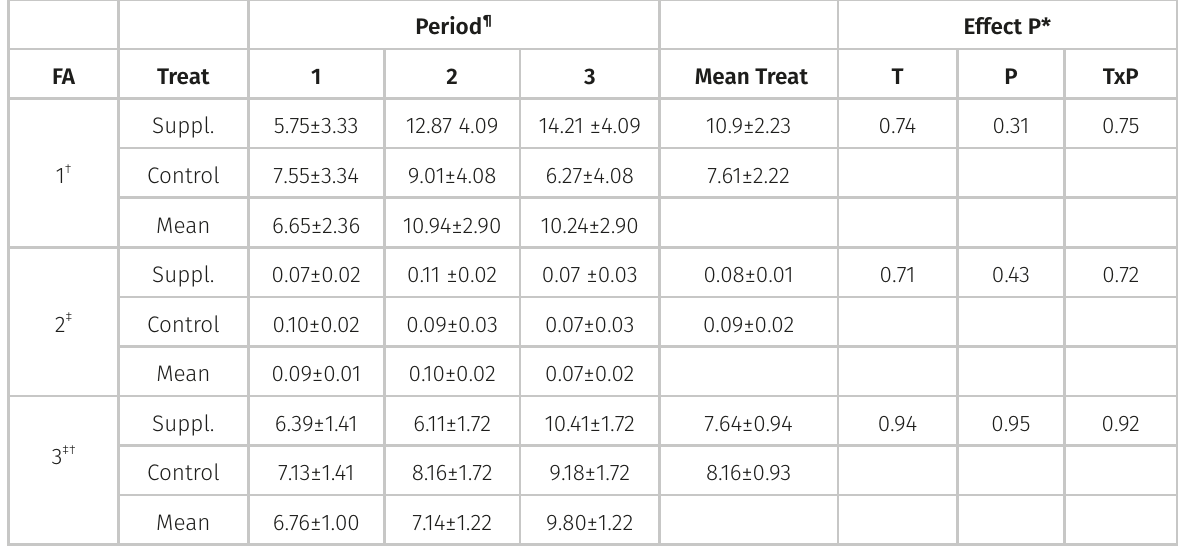
Table V. Effect of linseed-based vegetable with addition of salmon oil Canada supplementation on the